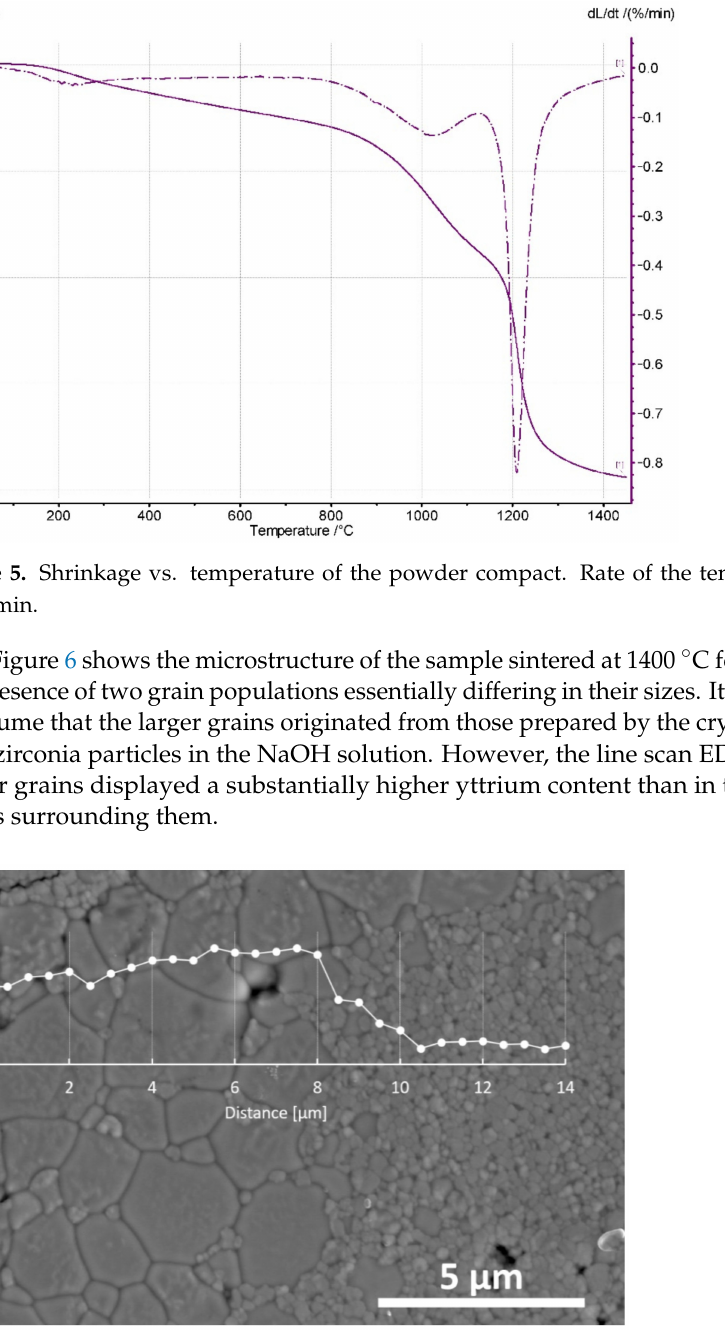
Figure 6. Changes of yttrium concentration across the indicated line of the sample sintered at 1400 ◦ C for 2